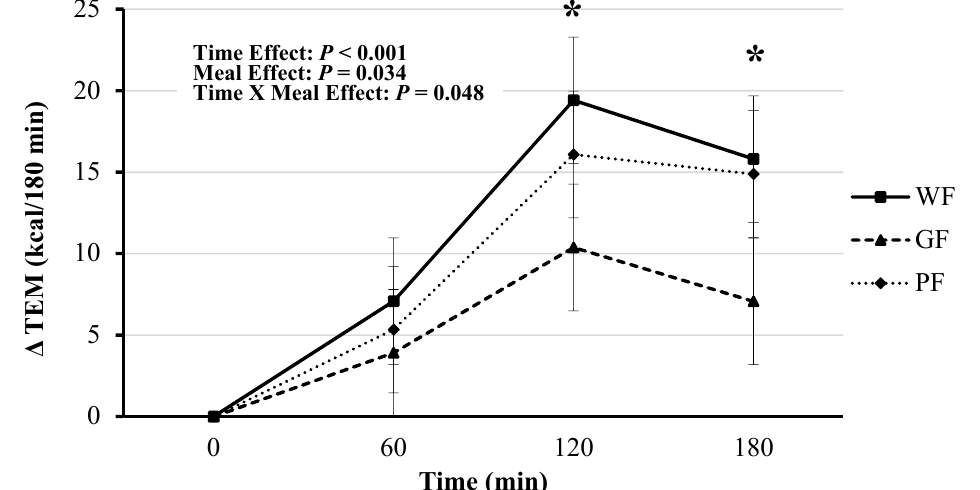
Figure 2. Comparison of postprandial thermogenic responses (TEM) to whole foods (WF), gluten-free (GF) and processed foods (PF) meals calculated as incremental area under the curve (AUC) for 0–60, 60–120, and 120–180-min periods. * Significance between AUC for WF and PF meals compared to the GF meal ( p < 0.05). Values displayed as means ±95% confidence intervals.